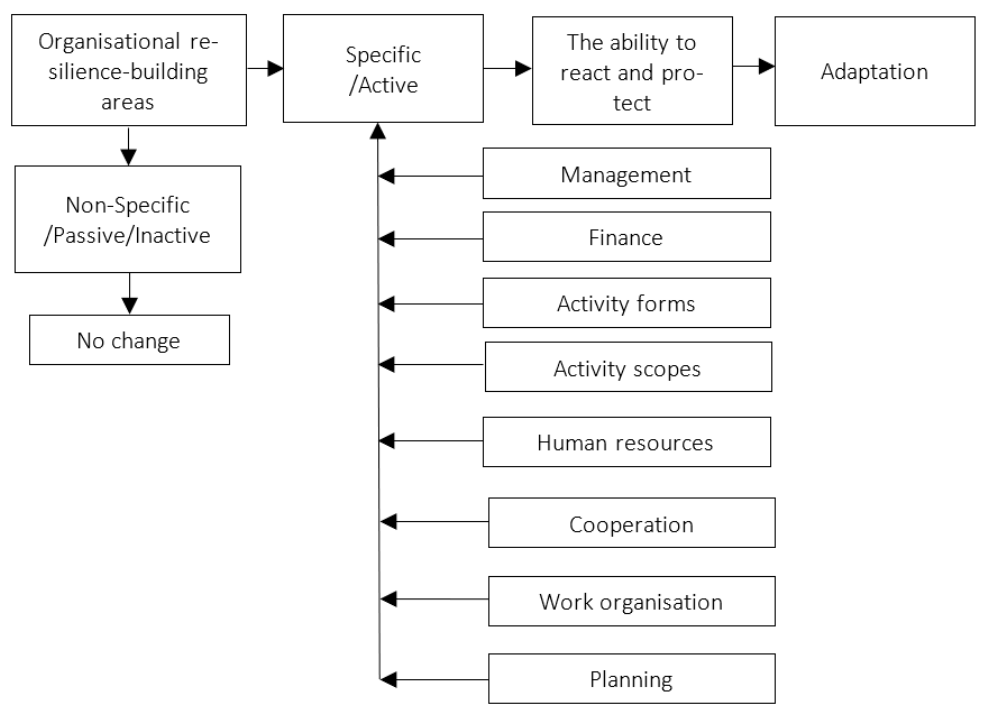
Figure 2. NPOs/RNPOs’ organisational resilience-building areas of activity. Source: authors’ elaboration based on literature review (see [57–60,66–71]).